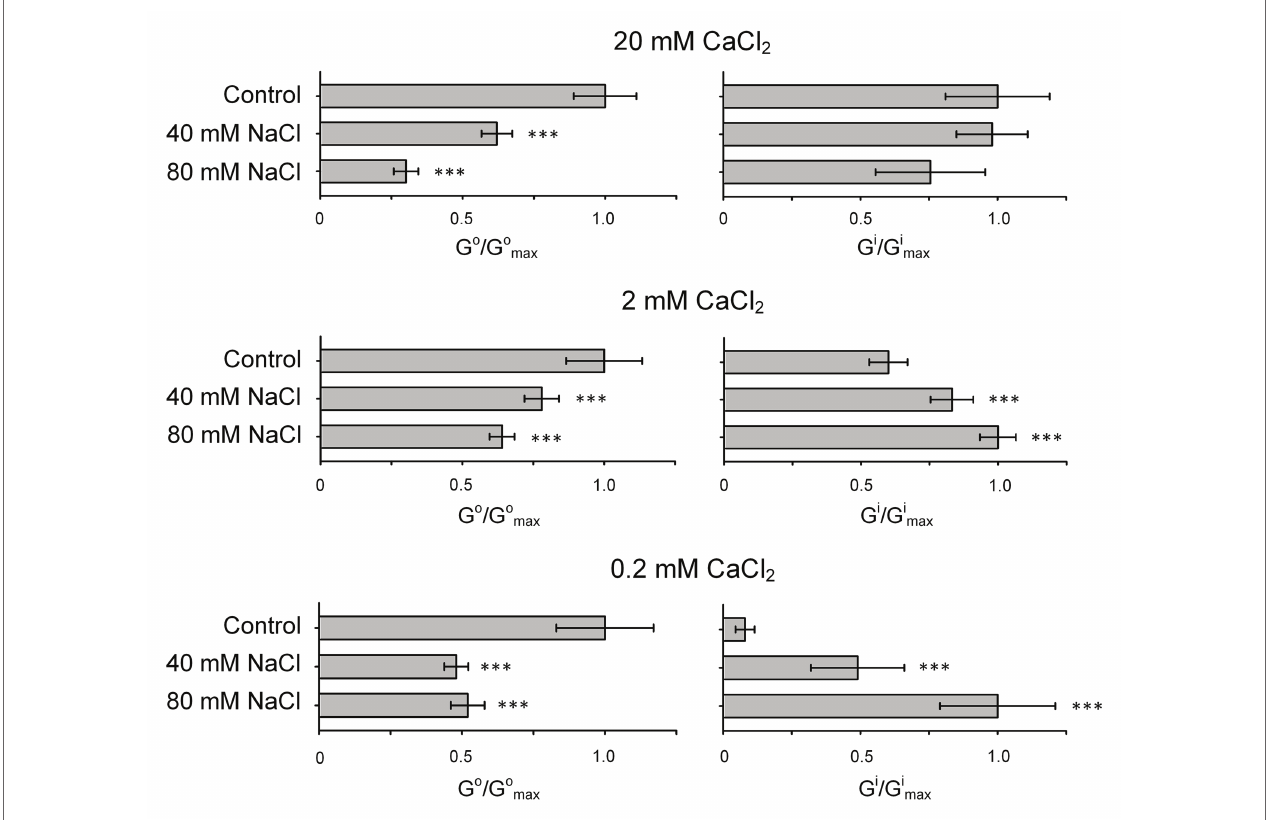
FIGURE 5 | Changes in outwardly (G o ) and inwardly (G i ) directed conductance in H. annuus L. root protoplasts induced by addition of 40 or 80 mM NaCl to the external solution. The outwardly directed and inwardly directed conductance values were calculated using currents induced by voltage segment within the reversal potential to 50 mV and − 180 mV, respectively (based on IV curves shown in Figures 2 – 4 ). G max is the maximal value of conductance measured calculated in an individual experiment (set of IV curves). Experimental conditions and ionic species in external and pipette solutions are same as in Figures 2 – 4 . Data are mean ± SE ( n = 5–11; *** p < 0.0001; ANOVA test; comparison to control; no significant difference where